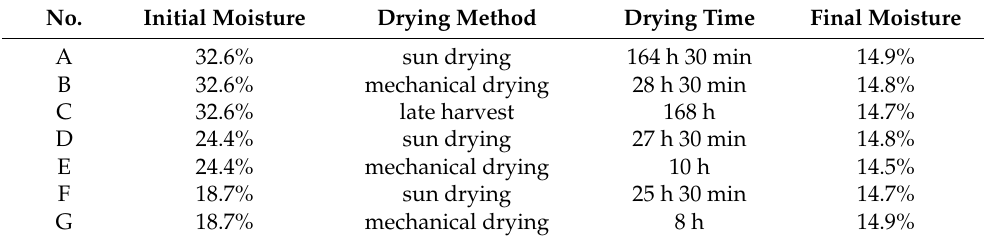
Table 1. Sample processing with different moisture content using different drying methods.